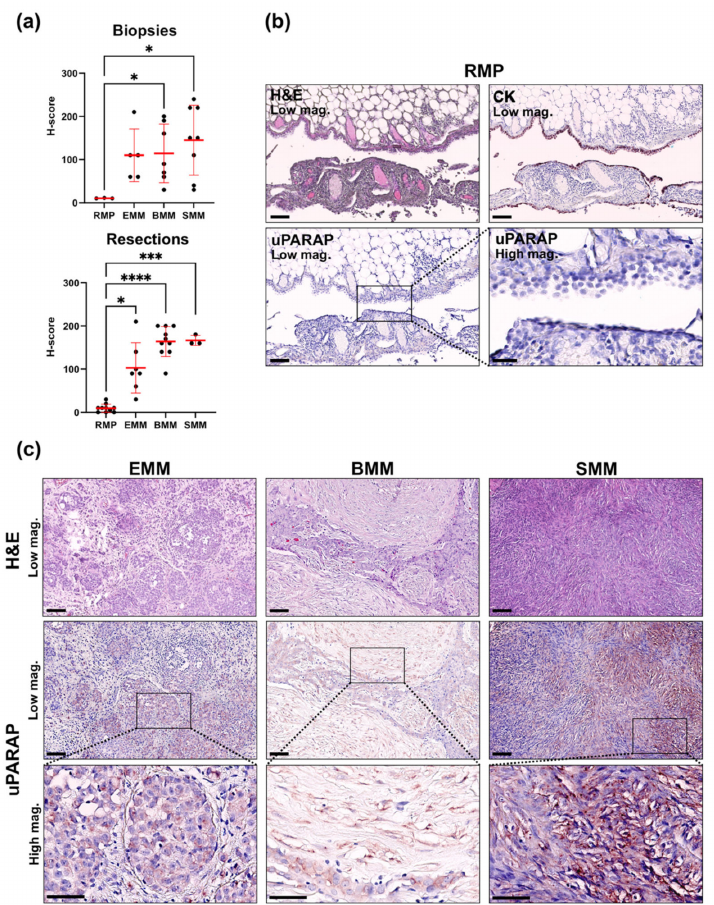
Figure 2. IHC analysis of uPARAP expression in tissue sections from MM and RMP. ( a ) Graphs indicate H-scores that were generated by uPARAP IHC analysis of FFPE tissue sections from biopsies taken from chemotherapy-naïve patients (upper graph: RMP ( n = 3), EMM ( n = 5), BMM ( n = 7), SMM ( n = 8)) or pleural resections from patients after neoadjuvant chemotherapy (lower graph: RMP ( n = 10), EMM ( n = 7), BMM ( n = 10), SMM ( n = 3)). Data are shown as mean ± SD for the individual MM subtypes and RMPs. Welch’s ANOVA test was used for the comparison of the groups. *: ( p ≤ 0.05), ***: ( p ≤ 0.0008), ****: ( p ≤ 0.0001). ( b ) Representative examples of H&E, uPARAP and pan-cytokeratin (CK) staining performed on parallel tissue sections from a pleural RMP induced by spontaneous pneumothorax. The CK staining highlights the CK-positive layer of hyperplastic mesothelium covering the pleura affected by chronic inflammation, vessel proliferation and mild fibrosis. The inset in the image from the corresponding uPARAP immunostaining (left) is illustrated at higher magnification (right) to highlight the lack of uPARAP expression in the hyperplastic mesothelium and underlying pleural stroma. ( c ) Representative examples of H&E and uPARAP staining performed on parallel tissue sections from samples representing the three MM subtypes (EMM, BMM, and SMM). The insets in the images from uPARAP immunostainings taken at low magnification (middle row) are illustrated at higher magnification at the bottom. High magnification bars: 100 µ m, low magnification bars: 50 µ